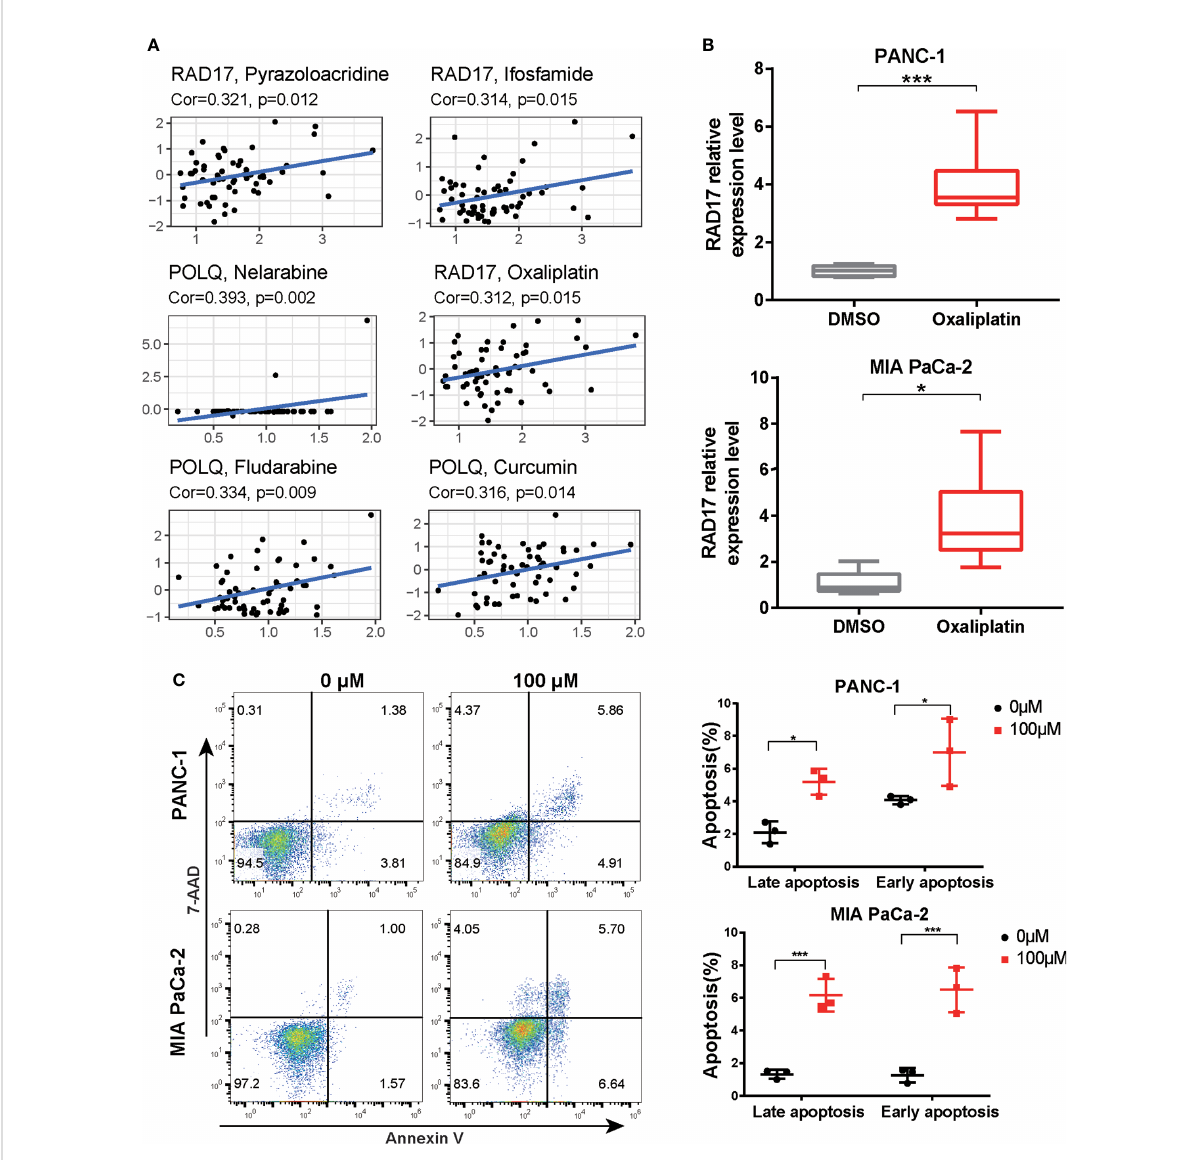
FIGURE 10 Expression levels of three DRGs in response to oxaliplatin treatment. (A) Correlation scatter plot showing the relationship between the IC 50 value of the drug in the CellMiner database and the expression levels of three DRGs in the signature. Six groups of relationships were selected. (B) PANC-1 and MIA PaCa-2 cells were treated with oxaliplatin for 24 h. The expression of RAD17 was measured by RT-qPCR. (C) PANC-1 and MIA PaCa-2 cells were treated with 100 m M oxaliplatin. The percentages of early and late apoptotic cells were determined and are shown in the right panel. *p < 0.05, ***p <